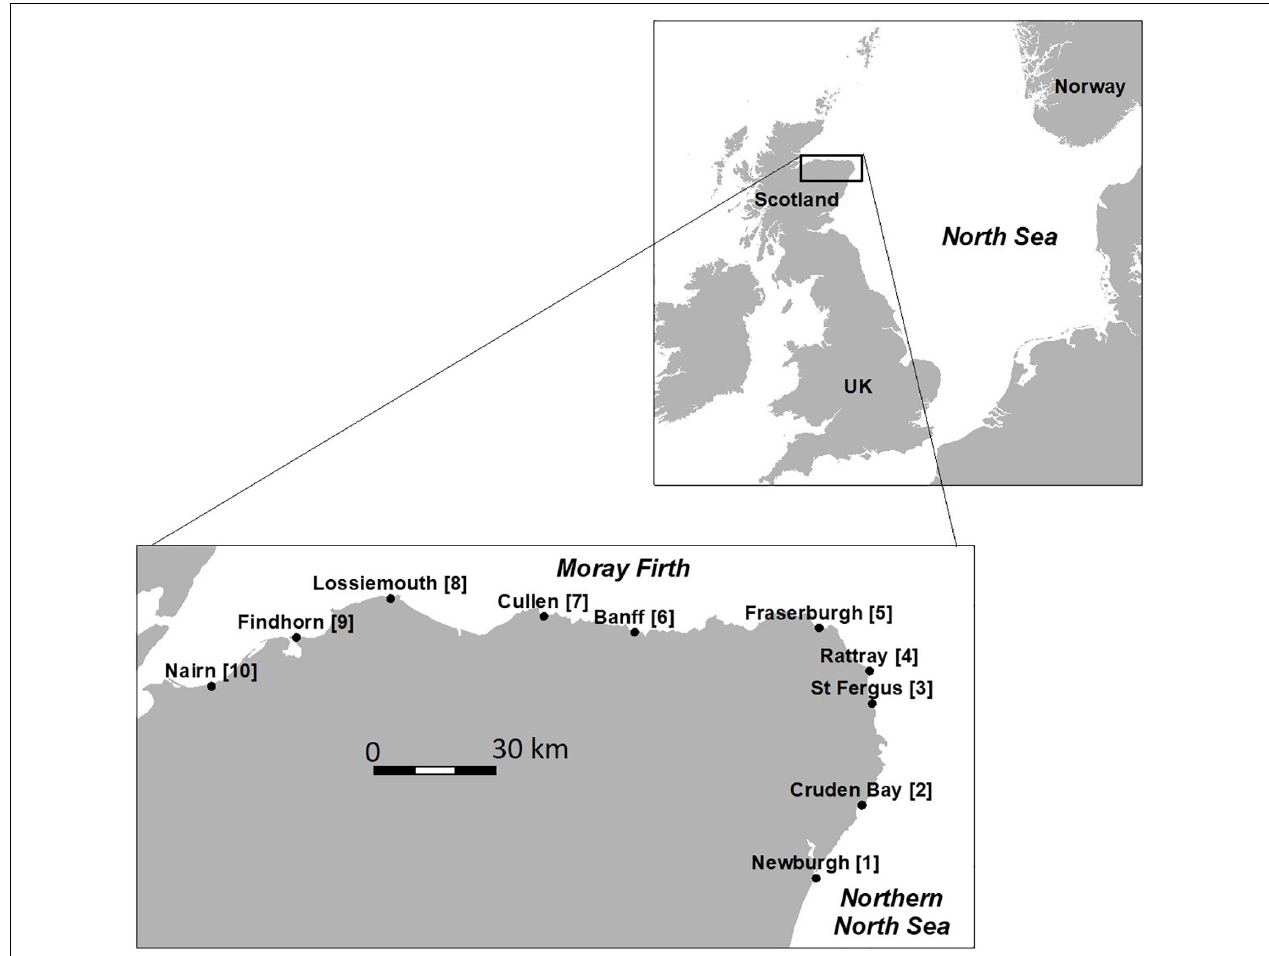
FIGURE 1 | Location of the 10 beach survey sites (2 survey sections per site) in northeast Scotland, and in relation to the North Sea. The sites were surveyed quarterly between the autumn of 2019 and the summer of 2020. Full details of each survey section are given in the Supplementary Material . Section numbers are given in square